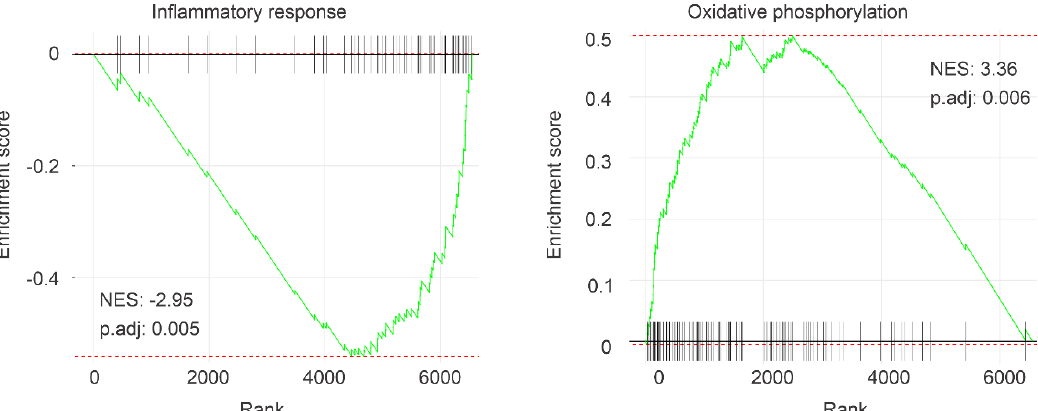
Figure 2. Gene set enrichment. IQGAP1 DEGs were analyzed for gene set enrichment among the human hallmark gene set. Two enriched gene sets functioning in the inflammatory response and oxidative phosphorylation are presented.